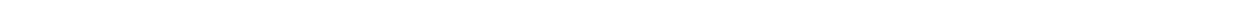
Fig. 3 Syt11 overexpression induces defects in striatal DA release and loss of dopaminergic neurons in the SNpc. a – c Representative amperometric currents ( I amp ) and statistics showing reduced DA release from Syt11-overexpressing (OE) dopaminergic terminals in the striatum. Syt11-carrying lentivirus was unilaterally injected into the SNpc and CFE recordings were made in striatal slices on both sides to compare the contralateral and ipsilateral (Syt11-OE) DA release ( P < 0.001, n = 10 pairs in slices from four mice). Insets: cumulative traces (charge) of I amp . d – f Normal striatal DA release from mice infected by control GFP-carrying lentivirus in the SNpc (amplitude, P = 0.730; charge, P = 0.947; n = 12 pairs in slices from 5 mice). g , h Syt11-OE induces apoptosis of DA neurons in the SNpc. Syt11-carrying lentivirus was unilaterally injected into the SNpc and dopaminergic neurons with TH staining were counted on both sides 3 months later (Control, P = 0.268; Syt11-OE, P = 0.004). TUNEL staining was used to detect apoptosis of dopaminergic neurons in the Syt11-OE SNpc ( n = 3 control and 4 Syt11-OE mice, biological repeats). i , j Unilateral Syt11-OE in the SNpc reduces the density of TH-positive fi bers in the ipsilateral striatum. The normalized fl uorescence intensity of TH staining in the striatum is shown in j (Control, P = 0.624; Syt11-OE, P = 0.009). Data were collected from three control mice and four Syt11-OE mice. Scale bars, 500 μ m (upper panel) and 100 μ m (middle and lower panels) in g , 20 μ m in i . Data are